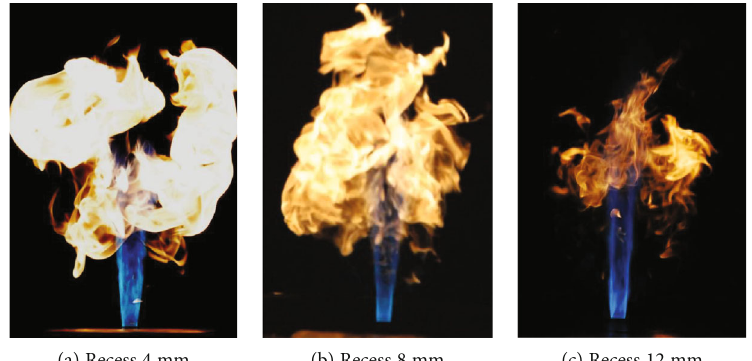
Figure 3: Flame patterns for several recess lengths of (a) 4mm, (b) 8 mm, and (c) 12 mm from the experiments of test no. 40 ( MFR = 12 : 37 , equivalenceratio = 1 : 033 , U = 14 : 3m/s , and U = 109m/s ). f o